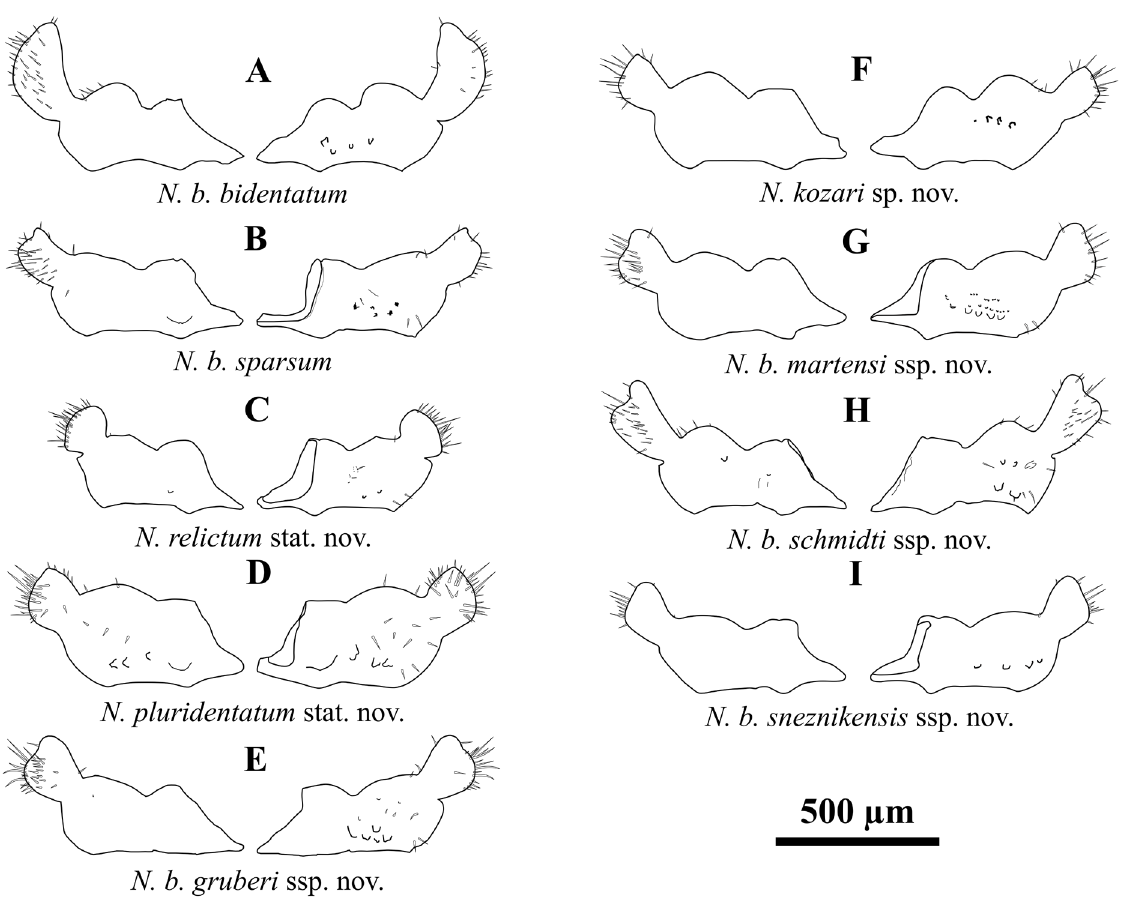
Fig. 4. Nemastoma bidentatum Roewer, 1914 complex, ♂♂. Ch basal articles (medial, lateral